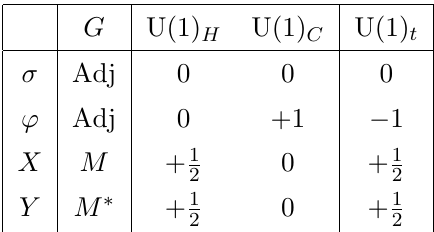
Table 1 . Summary of gauge and R-symmetry